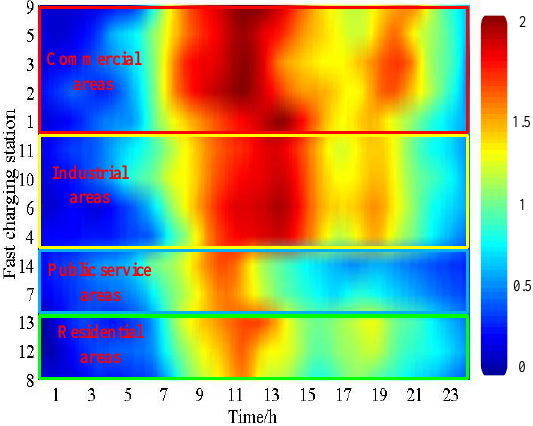
Figure 13. Charging demand load of fast-charging stations in each functional area.